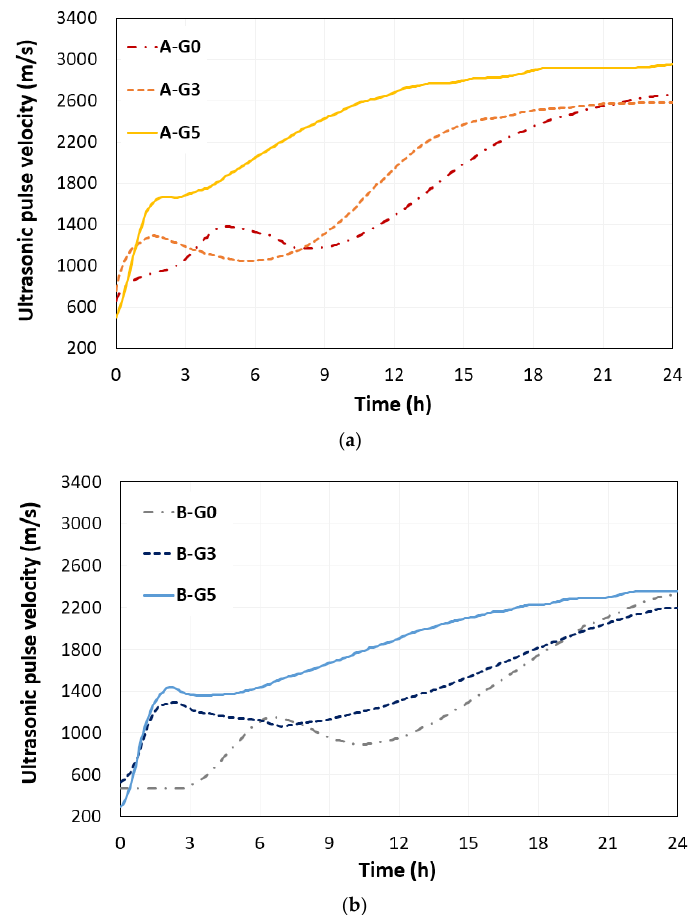
Figure 6. UPV measurements of early-age CSA cement paste with the different gypsum contents of 0% (G0), 3% (G3), and 5% (G5) under different water-to-binder ratios ( a ) 0.5 and ( b ) 0.55.